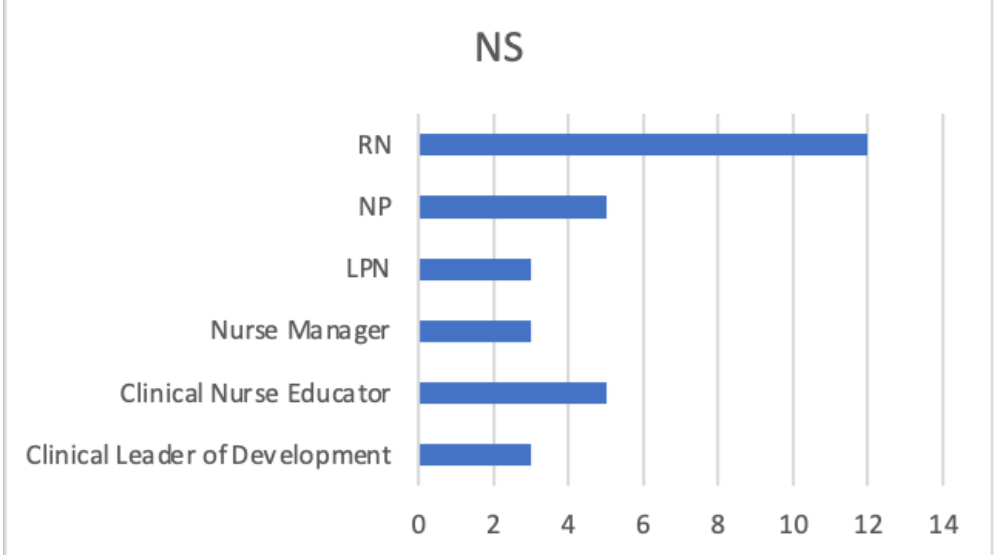
Figure 2: Nursing Profile of Nova Scotia Participants